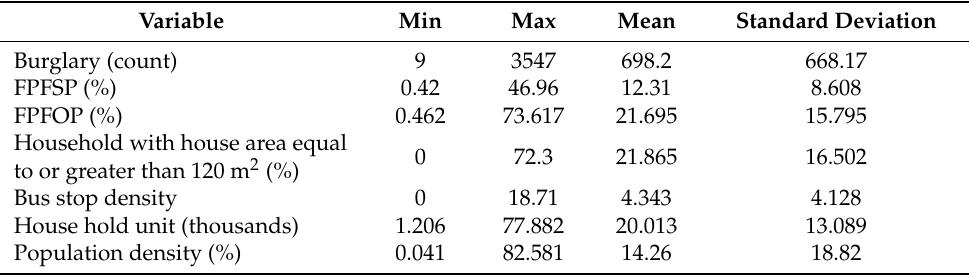
Figure 3. Distribution of residential burglary in 2013–2015. Table 1. Descriptive statistics of all variables in this study (Number of observations = 215).